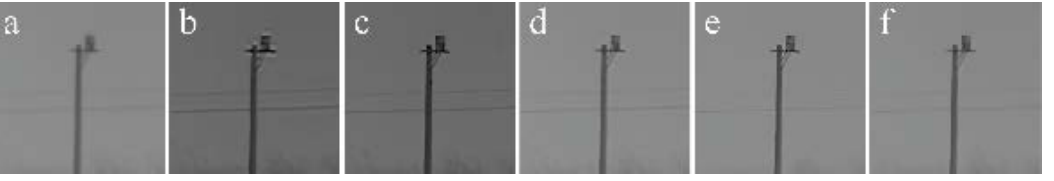
Figure 11. Comparison results for the “Chimney.bmp” image: ( a ) blurry image; ( b ) method in [35]; ( c ) method in [36]; ( d ) method in [37]; ( e ) method in [38]; ( f ) proposed method.